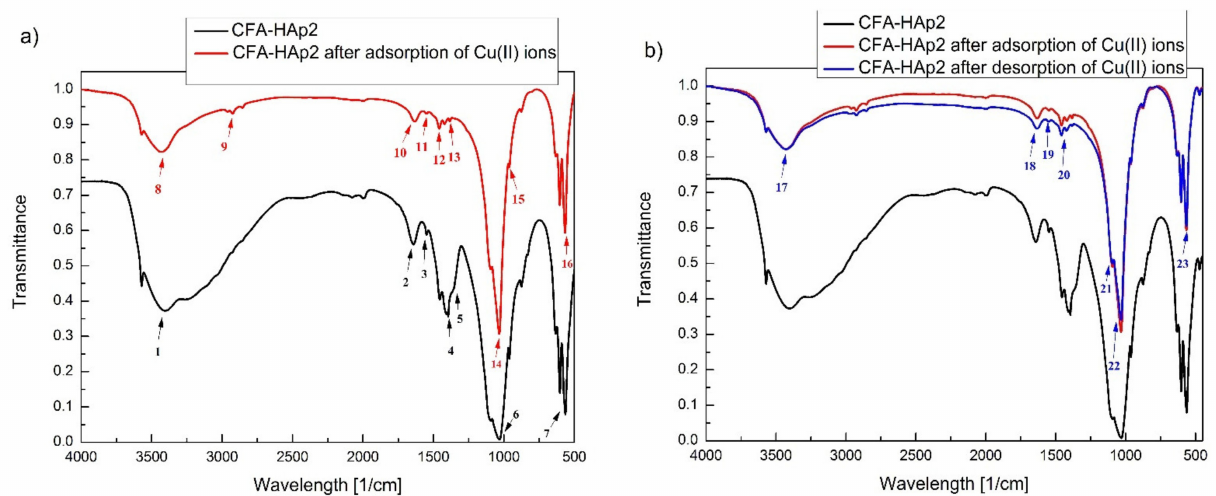
Figure 7. Comparison of FT-IR spectra of CFA–HAp2 samples: ( a ) before and after Cu(II) adsorption; ( b ) after Cu(II) adsorption and desorption.